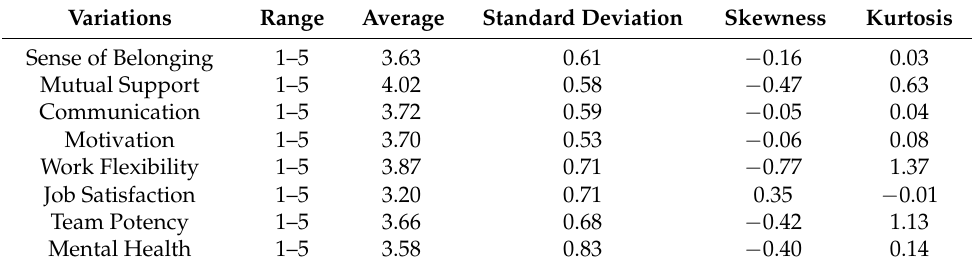
Table 5. Verification validation.